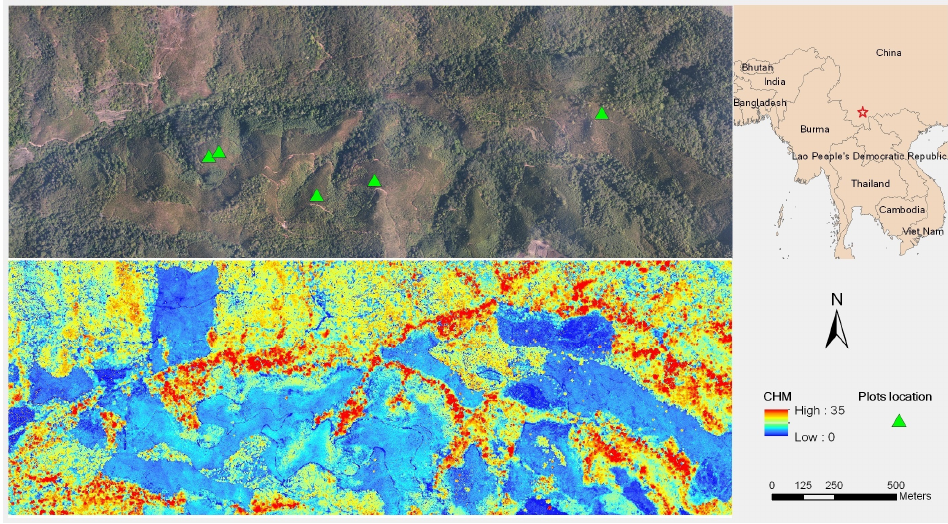
Figure 1. Plot locations, aerial photograph, and canopy height model (CHM) of the study area.